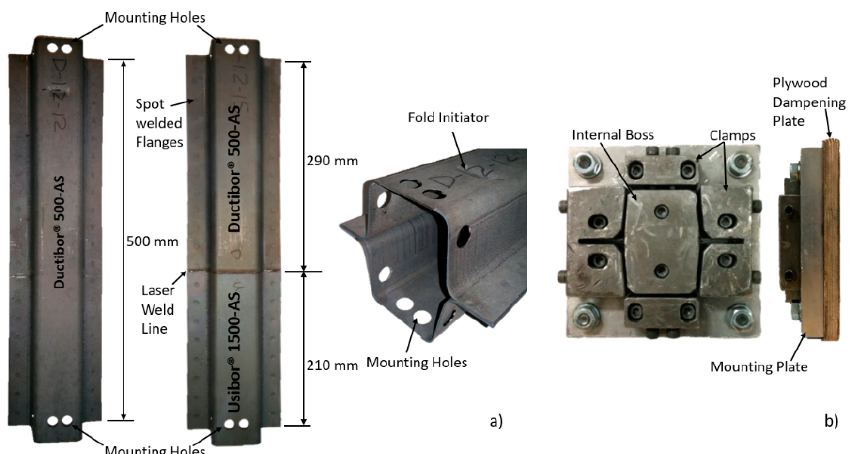
Figure 1. ( a ) Axial crush rail specimens; ( b ) Boss that is clamped to impacted end of the rail [6].